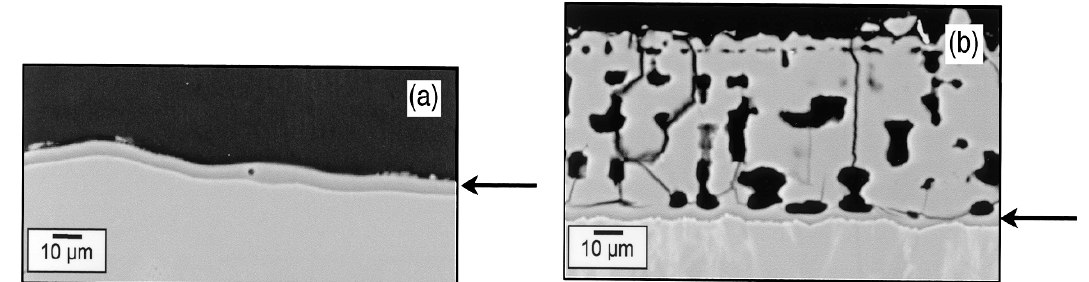
Figure 18. CVD-SiC seal coats after exposures in 1.5 atm H 2 O at the high gas velocity (~30 m/s) of ( a ) Solar Turbines combustor at ~1200 °C for 5016 h and ( b ) low gas velocity (~3 cm/min) of a laboratory furnace (ORNL rig) at 1200 °C after 500 h. Reprinted with permission from Reference [67]. Copyright 2003 The American Ceramic Society/Wiley. As was observed by Opila [63], the thickness of the thin film was constant with time, whereas the crystalline oxide layer was continually increasing. Therefore, the volatiliza- tion of the cristobalite layer is considered not to contribute to the SiC recession. In addi- tion, the high rate of the cristobalite growth could be predicted neither by the paralinear model nor by the presence of impurities. However, the fact that the dense layer does not thicken with time could be the expression of another paralinear regime. In this new model, the thickness of the dense layer becomes constant as the rate of its formation is equal to the rate of its transformation into a porous scale [66]. In the model of Haycock, two density